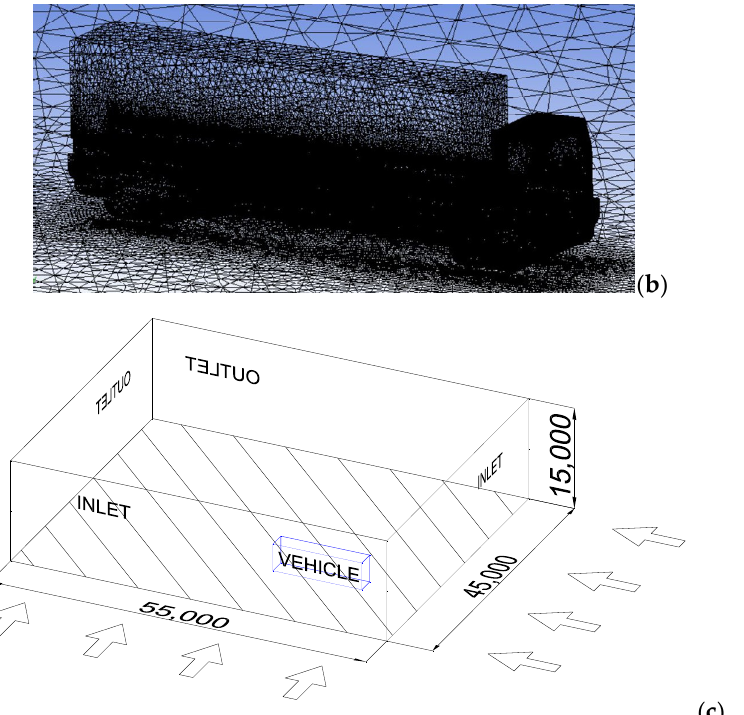
Figure 7. CFD model of railway wagon with semi-trailer truck, ( a ) internal geometry model, ( b ) mesh model, ( c ) model volume and airflow direction.